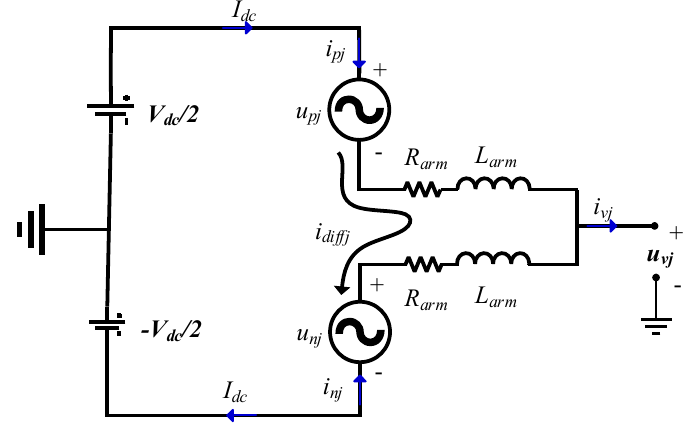
Figure 7. The one phase equivalent circuit.